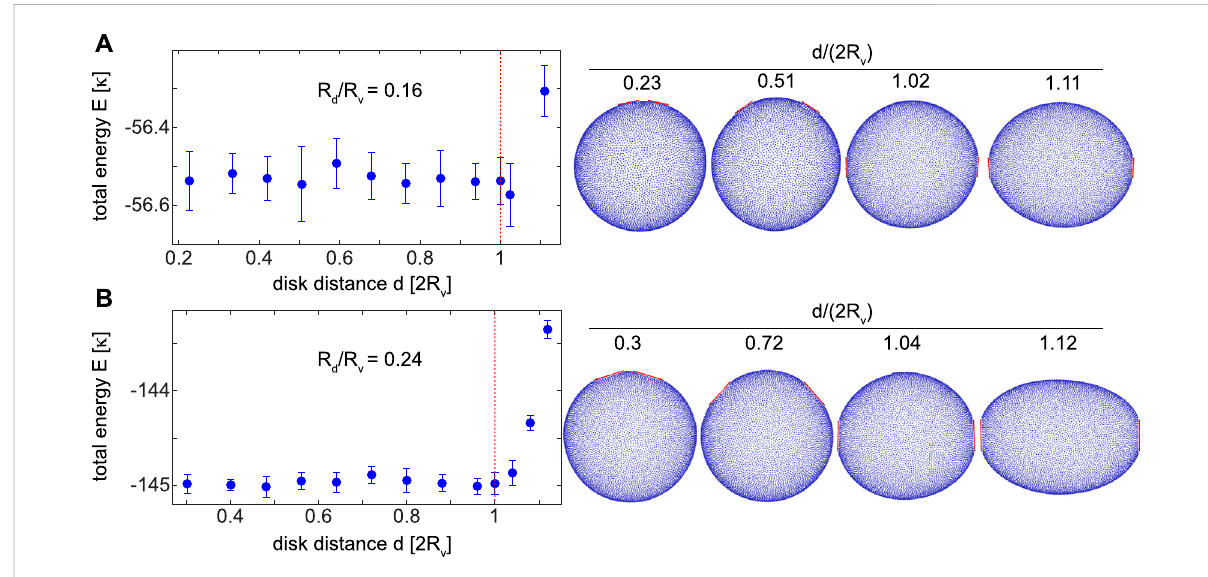
FIGURE 2 The total energy E / κ of a spherical vesicle with disks of relatively small sizes (A) R d / R v =0.16 and (B) R d / R v =0.24 with corresponding vesicle shapes in the right panels. Each point re fl ects the mean and the standard deviation of the total energy from ten simulations. Small disks experience short-range neutral interactions for disk distances below the vesicle diameter d ≤ 2 R v and long-range attraction beyond the vesicle diameter d ≥ 2 R v . The red dotted line corresponds to the diameter of the initial spherical vesicle d =2 R v